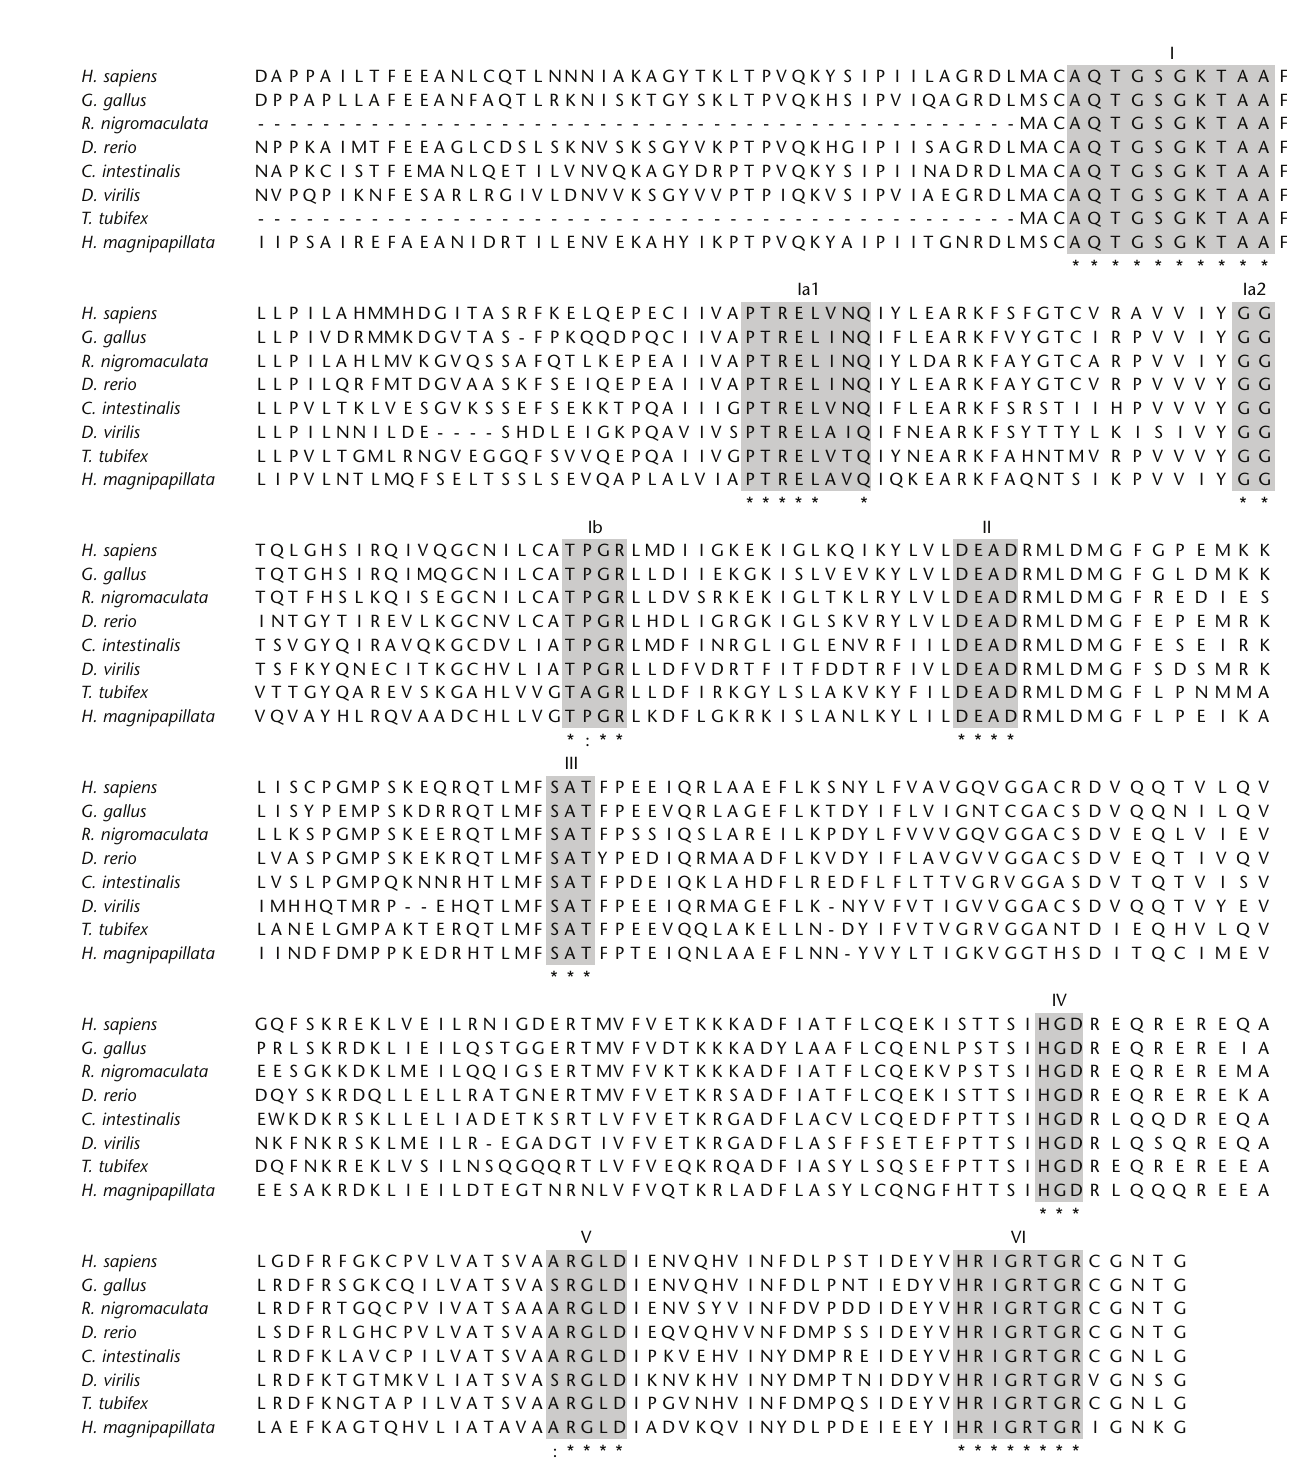
Figure 1. Alignment of the RnVasa protein sequence with the other vasa proteins included in the phylogenetic tree (Fig. 2). The characteristic motifs of Vasa proteins are shaded